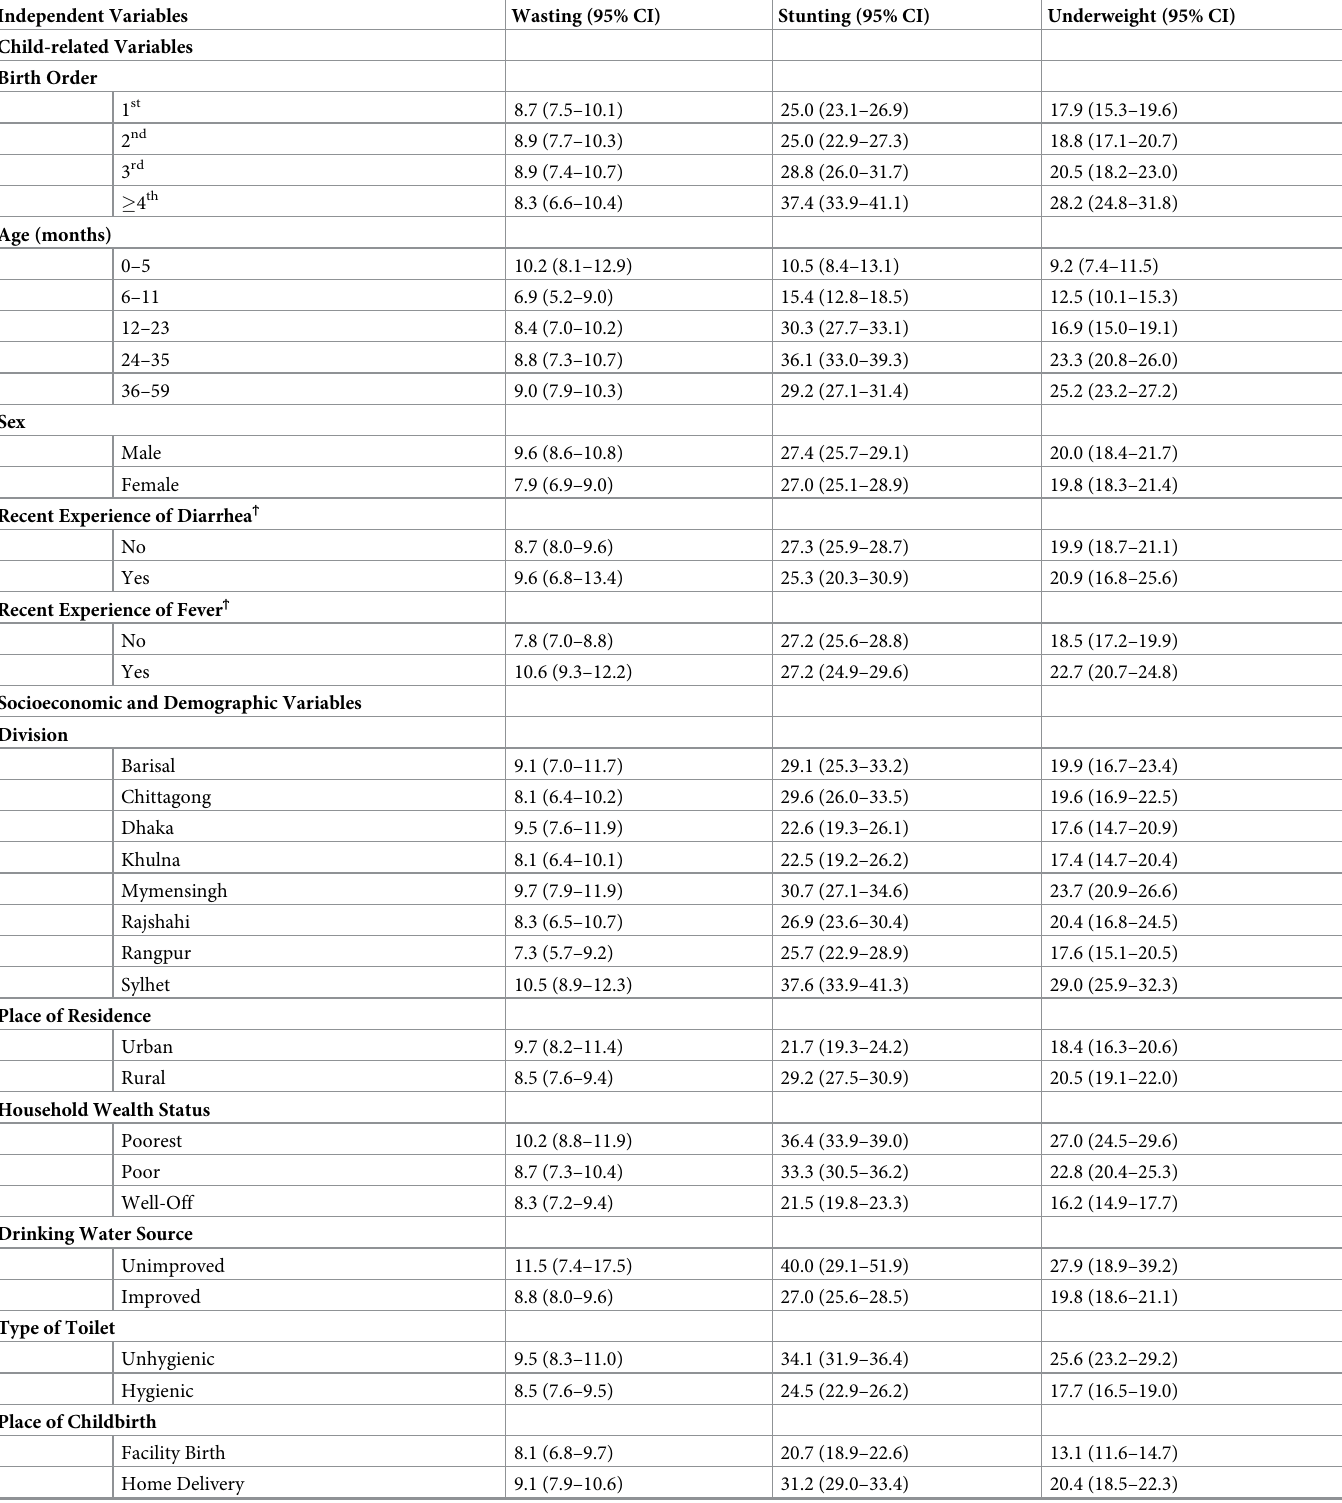
Table 2. Prevalence of malnutrition by background characteristics with 95% confidence interval (n =